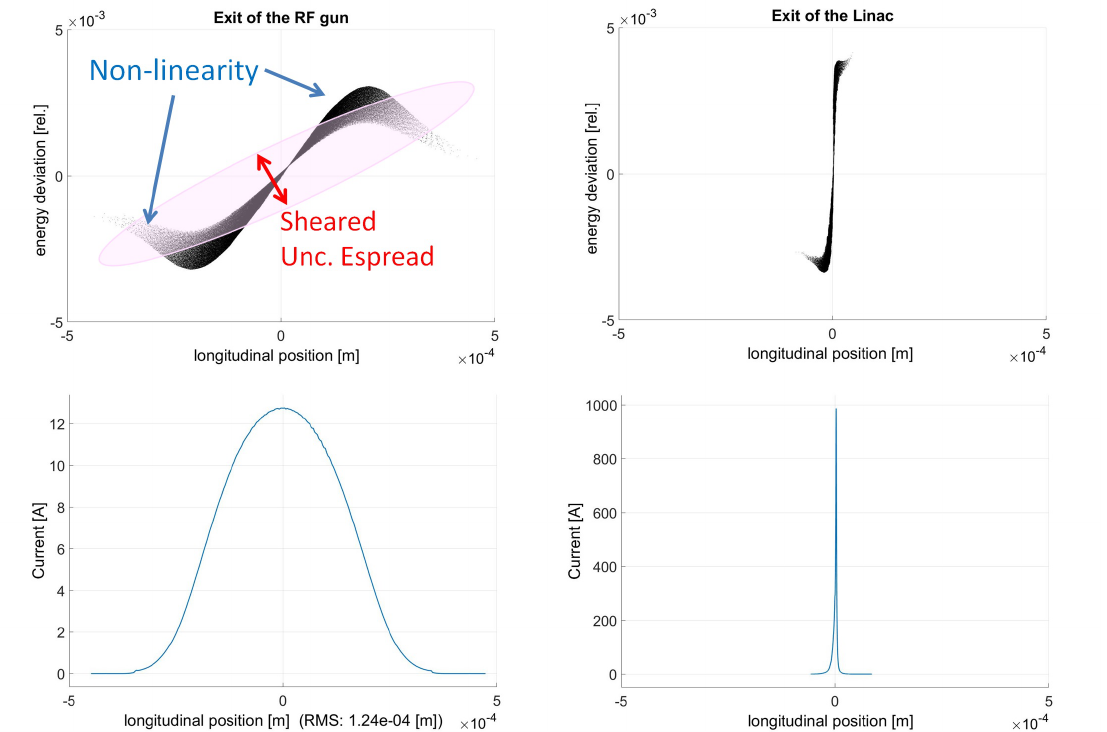
Figure 2. Example of the e-bunch phase space and relative charge profile versus time at the RF gun exit ( left ) and at its maximum compression point ( right ). The limitation caused by phase space non-linearities and uncorrelated energy spread is illustrated. The simulations have been performed using the code ASTRA